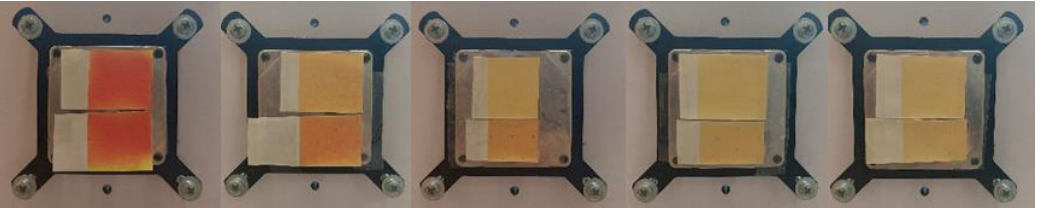
Figure 10. Visual presentation of thermochromic prints of cold activated TC ink OY-12 at 8 °C, before and after exposure of samples to UV radiation unexposed and exposed (6, 12, 18, and 24 h) (above CHR sample, below NMF sample).